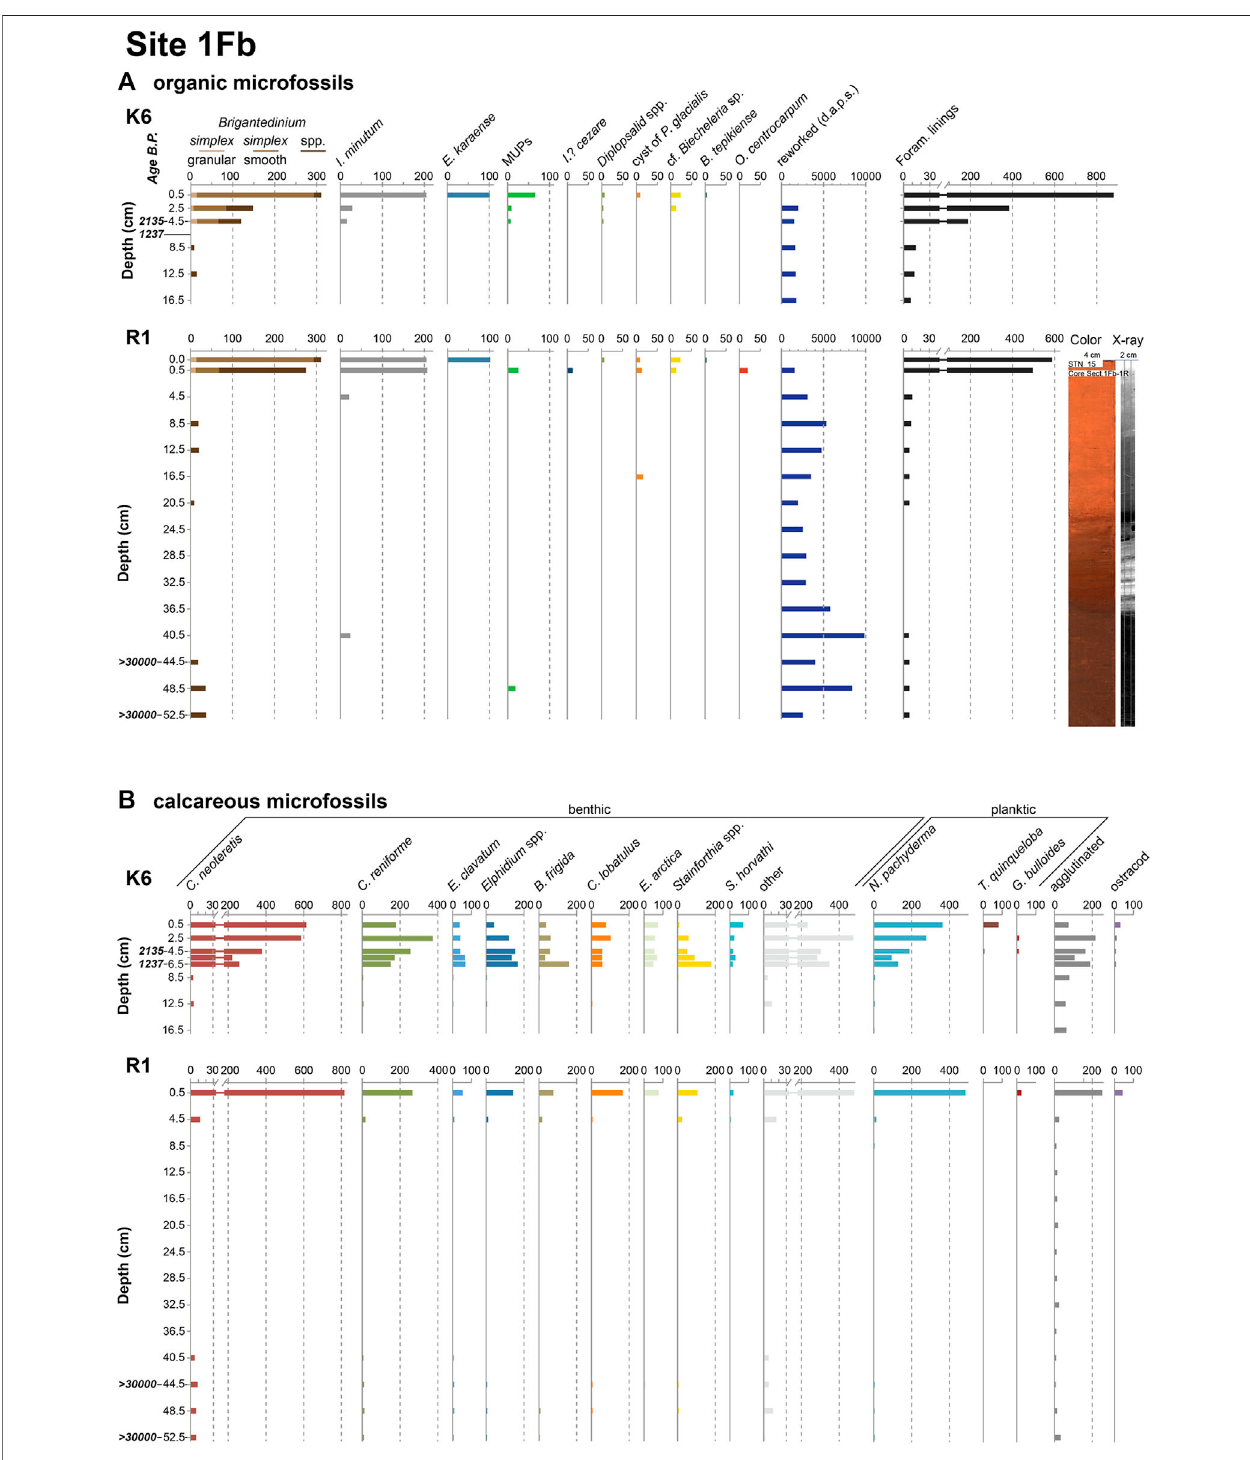
FIGURE 2 | (A) Palynological and (B) foraminiferal and other calcareous microfossil concentrations (specimens per gram dry sediment) for cores K6 and R1, site 1Fb. The reworked palynomorphs include pre-Quaternary dinocysts, acritarchs, pollen, and spores (d.a.p.s.). Also shown are the color and X-ray scans of the longer core R1. All levels thatwere analyzed are indicated witha tickmark and alabel on thedepth axis,and as such also include barren samples. Calibrated radiocarbonages are also indicated.